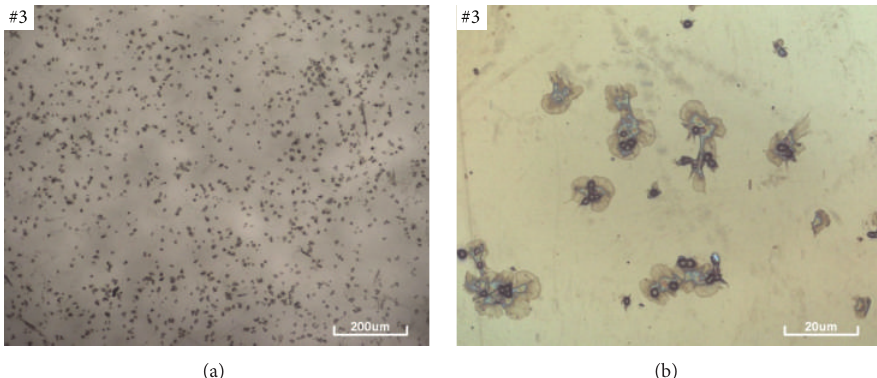
Figure 5: Optical image of platelets on surface of PET polymer treated in oxygen plasma and coated with heparin (#3) after incubation with fresh blood at two different magnifications ((a) and (b)).